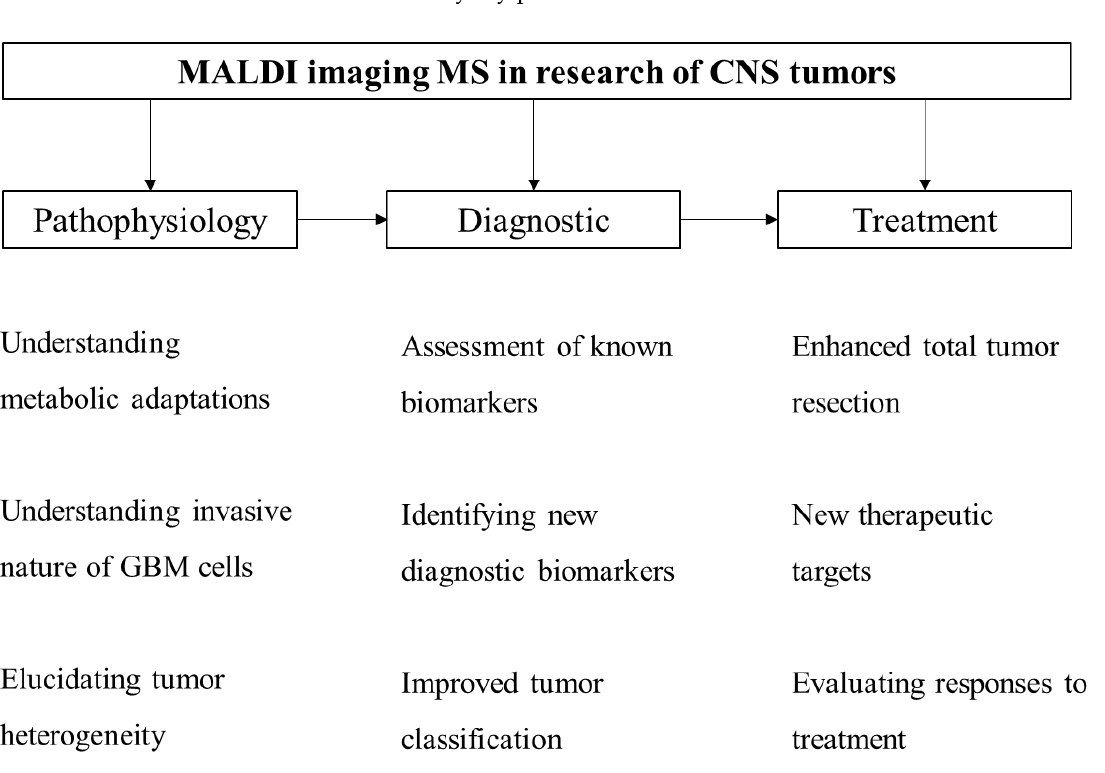
Figure 2. MALDI imaging MS in research of CNS tumors could improve our understanding of the pathophysiology of the disease, which could enhance diagnostic process and ultimately improve treatment options and overall survival of GBM patients.